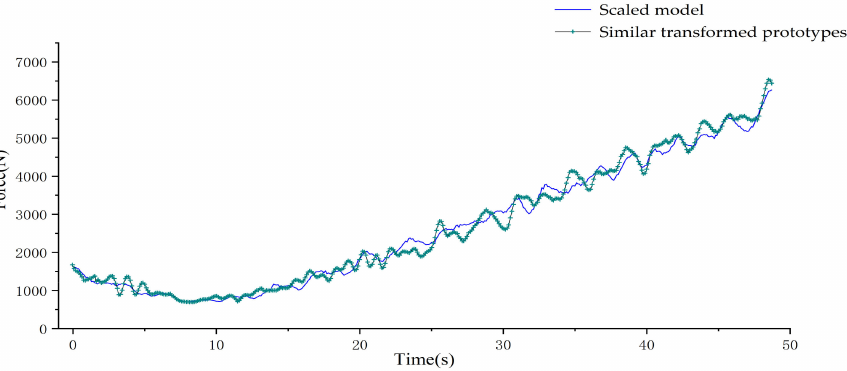
Figure 15. Comparisons of stresses at the joint of the tower and support under tensioner support.